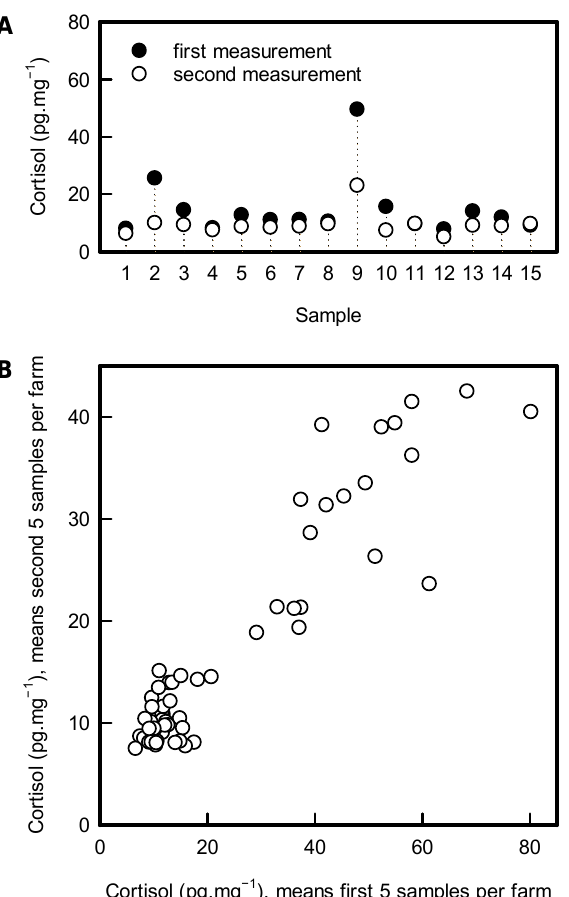
Figure 2. Panel ( A ): Difference in cortisol values from the 15 samples processed and measured within 4 months and one year after sampling. Panel ( B ): Pairwise plot of the untransformed hair cortisol means of the first 5 samples and means of hair cortisol values of second 5 samples per farm.